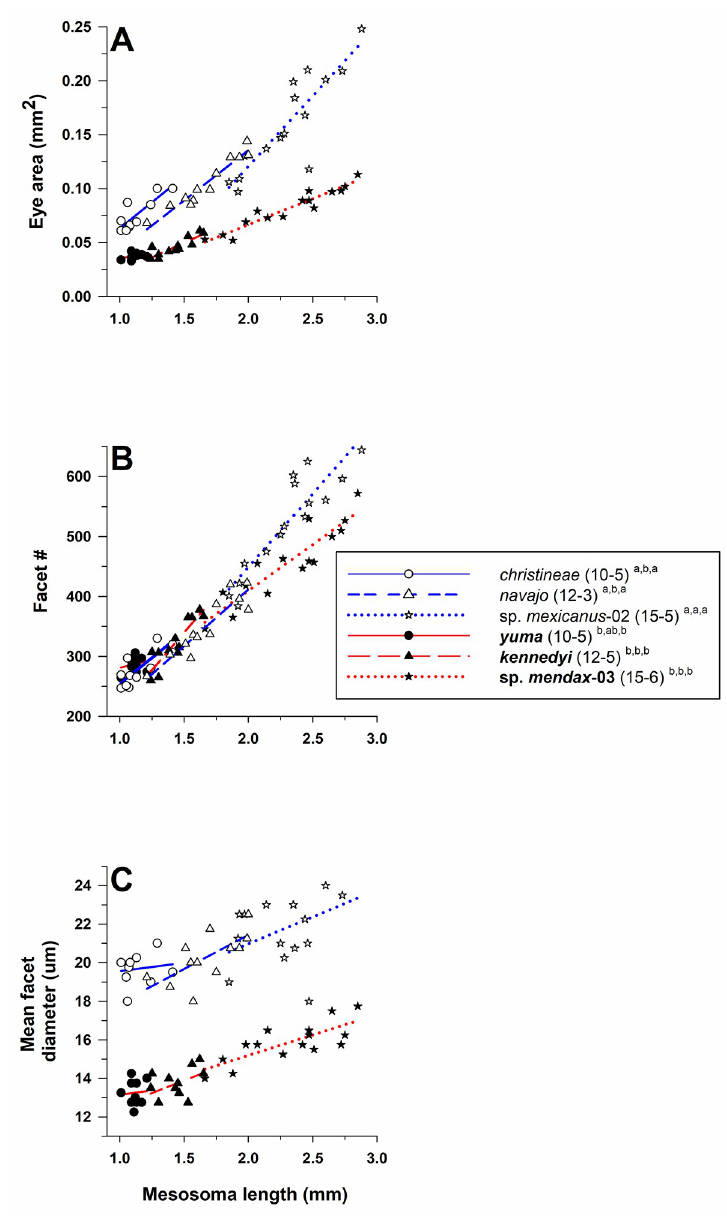
Fig 5. Eye area (mm 2 ) (A) , facet number (B) , and mean facet diameter ( D ) ( μ m) (C) for species of Myrmecocystus (subfamily Formicinae: tribe Lasiini). Three species are pale (open symbols, normal font, and blue lines: M . christineae , M . navajo , M . mexicanus -02), and three species are dark (filled symbols, bold font, red lines: M . yuma , M . kennedyi , M . mendax -03 ) (see text). For each species, number of workers examined and number of colonies they were derived from is given in parentheses. Significant differences ( P < 0.05) among species are denoted after each species name by the letters a–c : a > b > c ; the three sets of letters for each species correspond to panels A, B, and C, respectively. Groupings are based on univariate F tests within MANCOVA using the estimated marginal means followed by pairwise comparisons using a least significant differences test (see